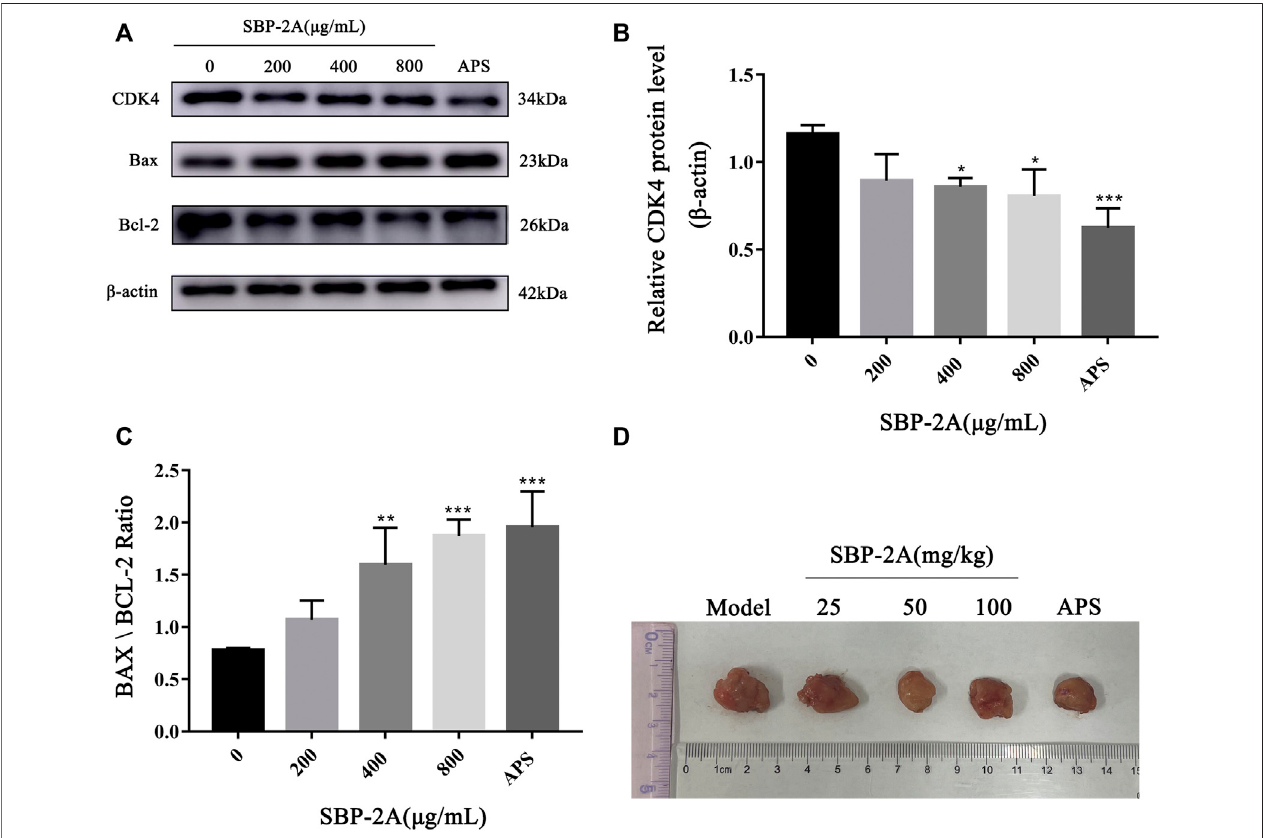
FIGURE 10 | The protein expression of CDK4, Bax and Bcl-2 (A – C) . Contrast to the without SBP-2A group, * p < 0.05, ** p < 0.01, *** p < 0.001. H22 mice tumor (D) .